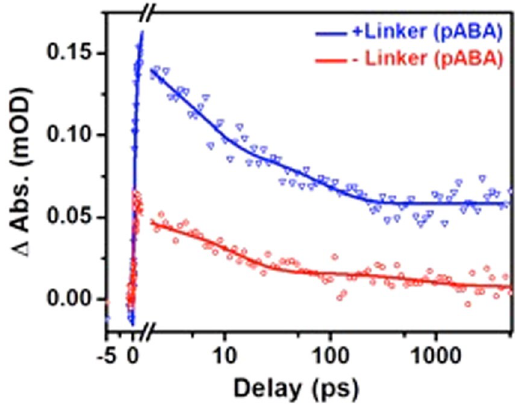
Figure 3. Effect of linking Ag NPs to TiO 2 with a molecular linker to the ultrafast transient infrared absorption signal. Kinetic traces extracted at 2081 cm − 1 from transient absorption infrared spectroscopy measurements upon excitation at 405 nm for the Bts-Ag NP–linker–TiO 2 (linked system, + linker (pABA)) and Bts-Ag NP– TiO 2 (unlinked system, – linker